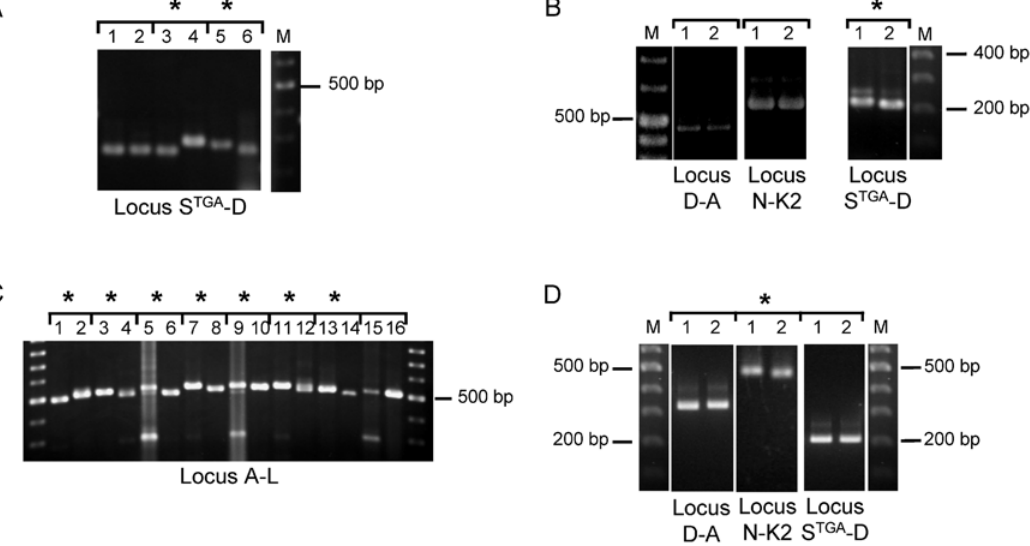
Figure 1. PCR product size polymorphism in paired samples. PCR product size polymorphism at selected STR loci using DNA samples from liver abscess (odd numbered lanes) and stool specimens (even numbered lanes) from the following amebic liver abscess patients: A. BAN-1 (1 & 2), BAN-2 (3 & 4) and BAN-3 (5 & 6). B. The Italian amebic liver abscess patient. C. BAN-4 (1 & 2), BAN-5 (3 & 4), BAN-6 (5 & 6), BAN-7 (7 & 8), BAN-8 (9 & 10), BAN-9 (11 & 12), BAN-10 (13 & 14) and BAN-11 (15 & 16). D. The USA amebic liver abscess patient. Asterisks indicate a PCR product size difference in the paired samples. A more complete set of PCR products can be seen in Figure S3.